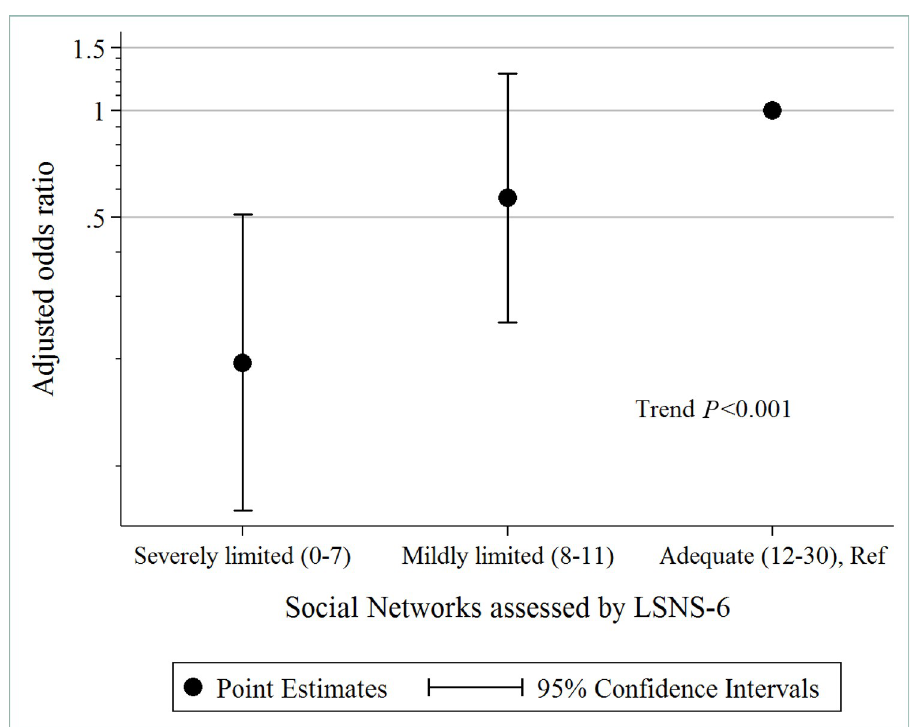
Fig 1. Odds ratio of occurrence of advance care planning discussion by Lubben Social Network Scale. Abbreviations: LSNS-6, Lubben Social Network Scale; Ref, Reference.